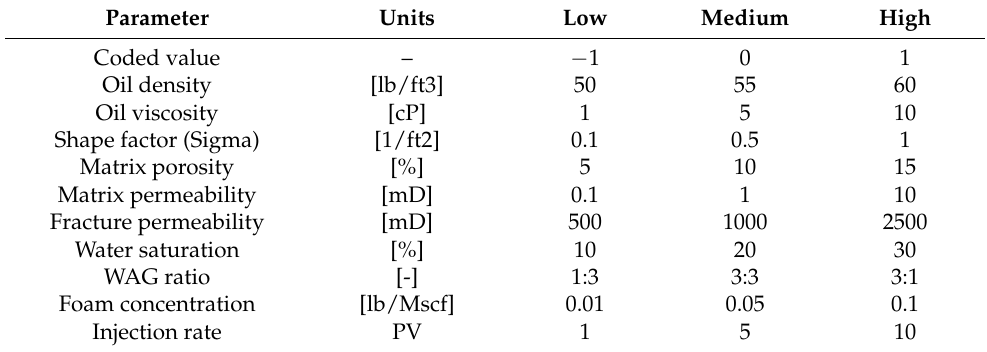
Table 1. Range of parameters used in the gas, foam, WAG, and FAWAG simulation.